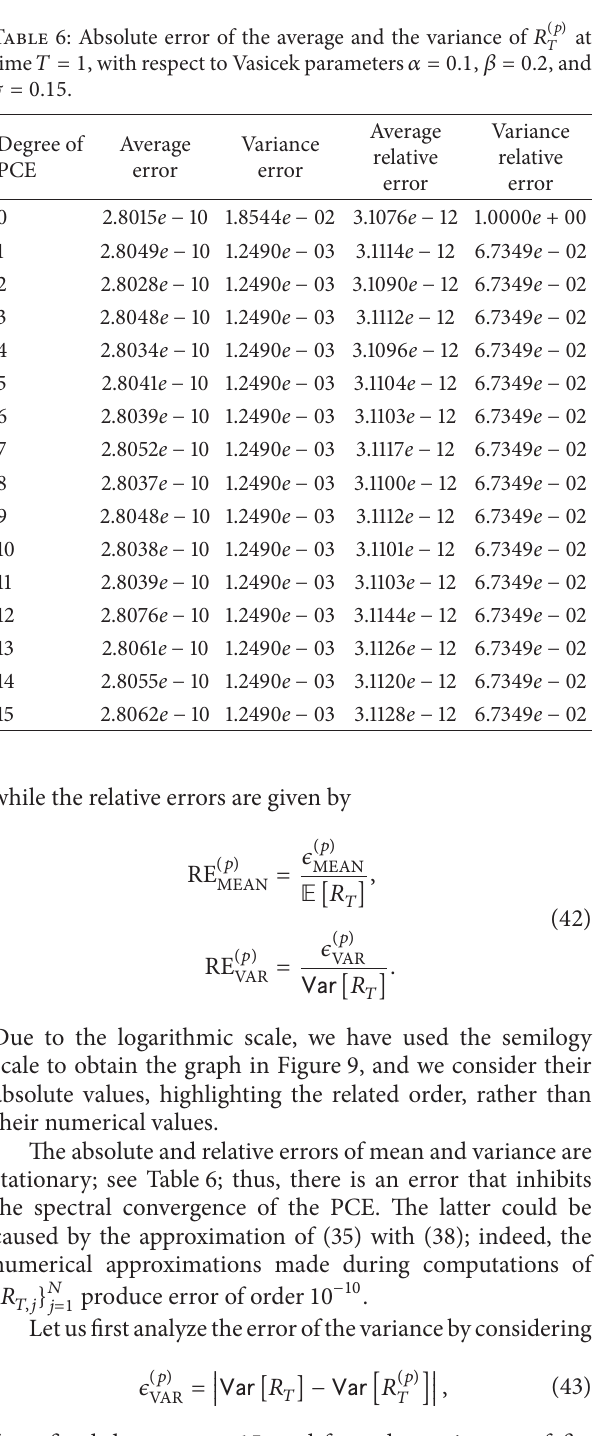
̂𝑄 ̂𝑄 99 % and 99.9 % of the